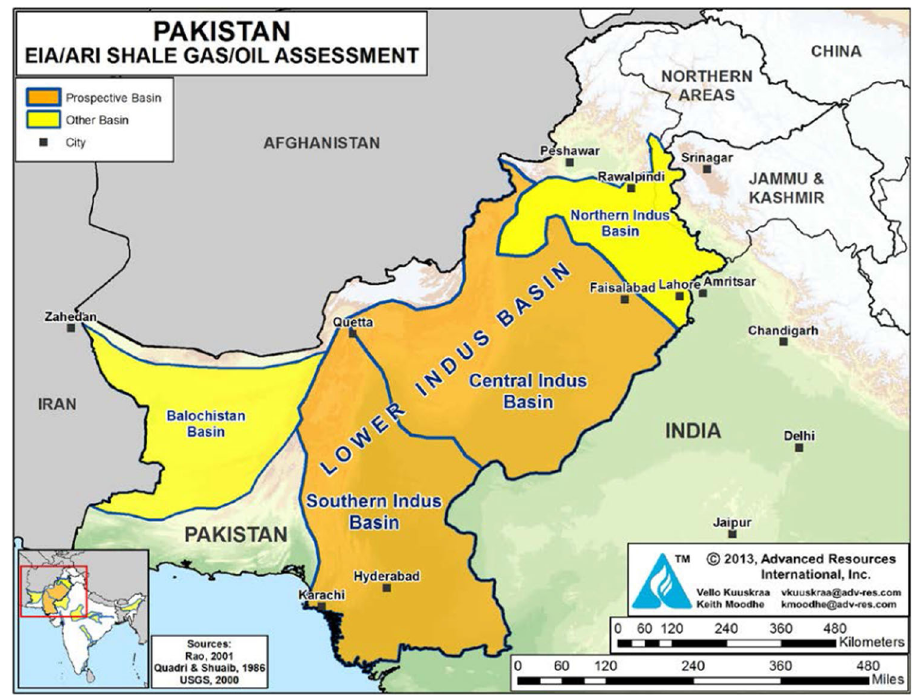
Fig. 7 Pakistan’s shale gas status based on EIA and ARI shale gas/oil assessment report Reproduced with permission from ARI